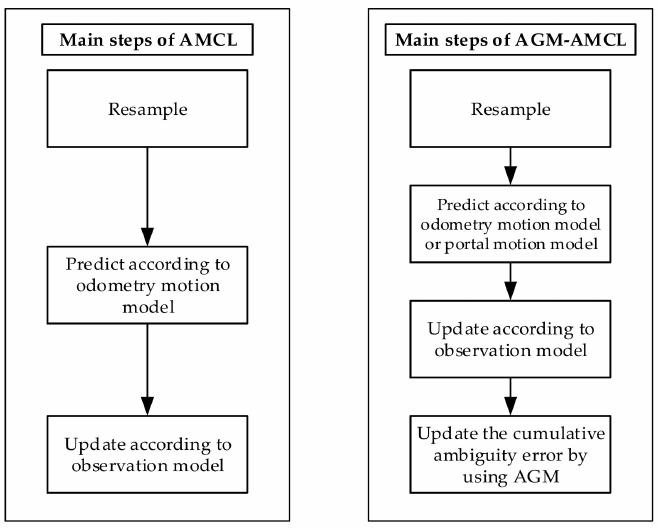
Figure 3. Main steps of AMCL and our